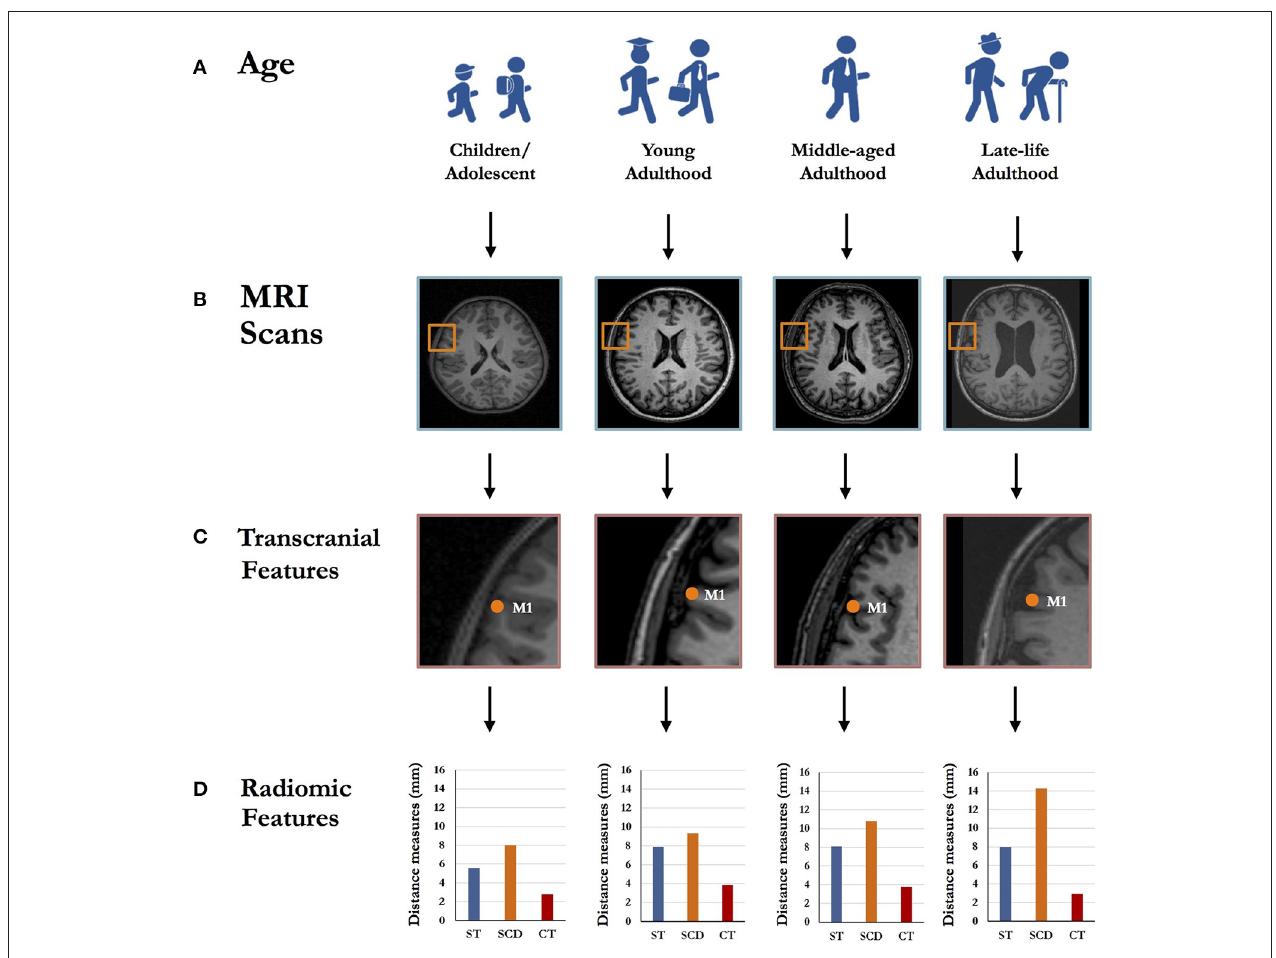
FIGURE 1 | Schematic representation of the region-specific radiomic features differences across the individuals with different age ranges, including children/adolescent, young adulthood, middle-aged adulthood and late-life adulthood (A) . Taking primary motor cortex (M1) as an example, left M1 was localized by the Montreal Neurological Institute (MNI) coordinates through T1-weighted structural magnetic resonance imaging (MRI) scans (B) . The radiomic features in transcranial model (C) , including skull thickness, scalp-to-cortex distance and cortical thickness, vary across the individuals with different age ranges (D) . ST, Skull thickness; SCD, Scalp-to-cortex distance; CT, Cortical